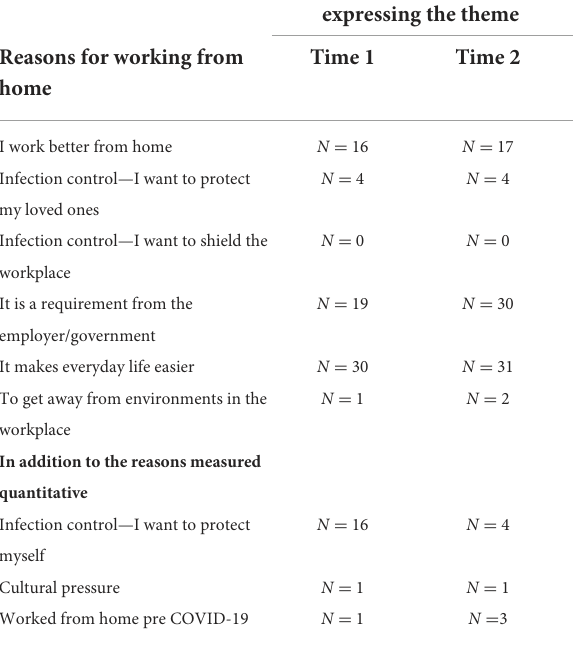
TABLE 3 Reasons for working home identified in participant’s comments (qualitative, open-ended